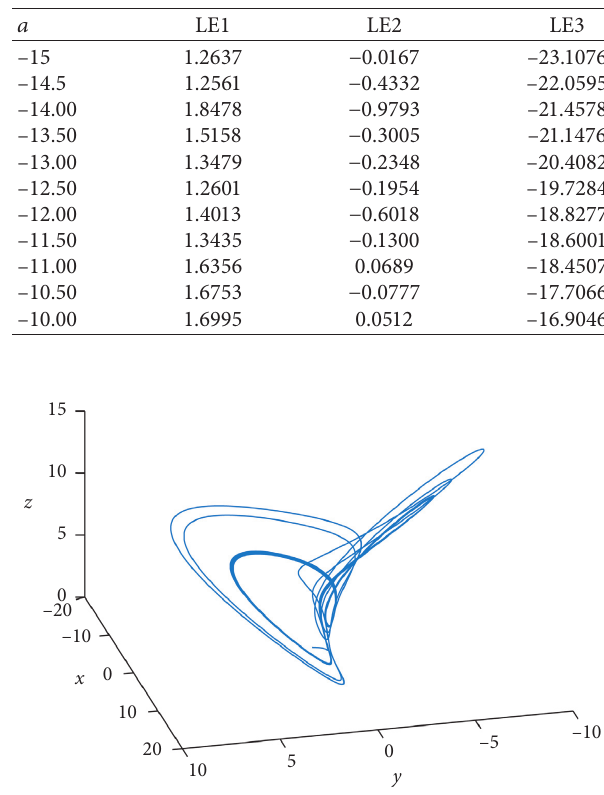
Figure 17: Dynamics of the fractional-order system in (13)–(15) with the order α � 0 . 92, in context of x , y , and z Figure 21 the dynamics of the fractional-order system in (13)–(15) in the context of x , y , and z directions, with the order α � 0 . 92. We depict in Figure 22 the dynamics of the fractional- order system in (13)–(15) in context of y and z directions, with the order α � 0 . 92.